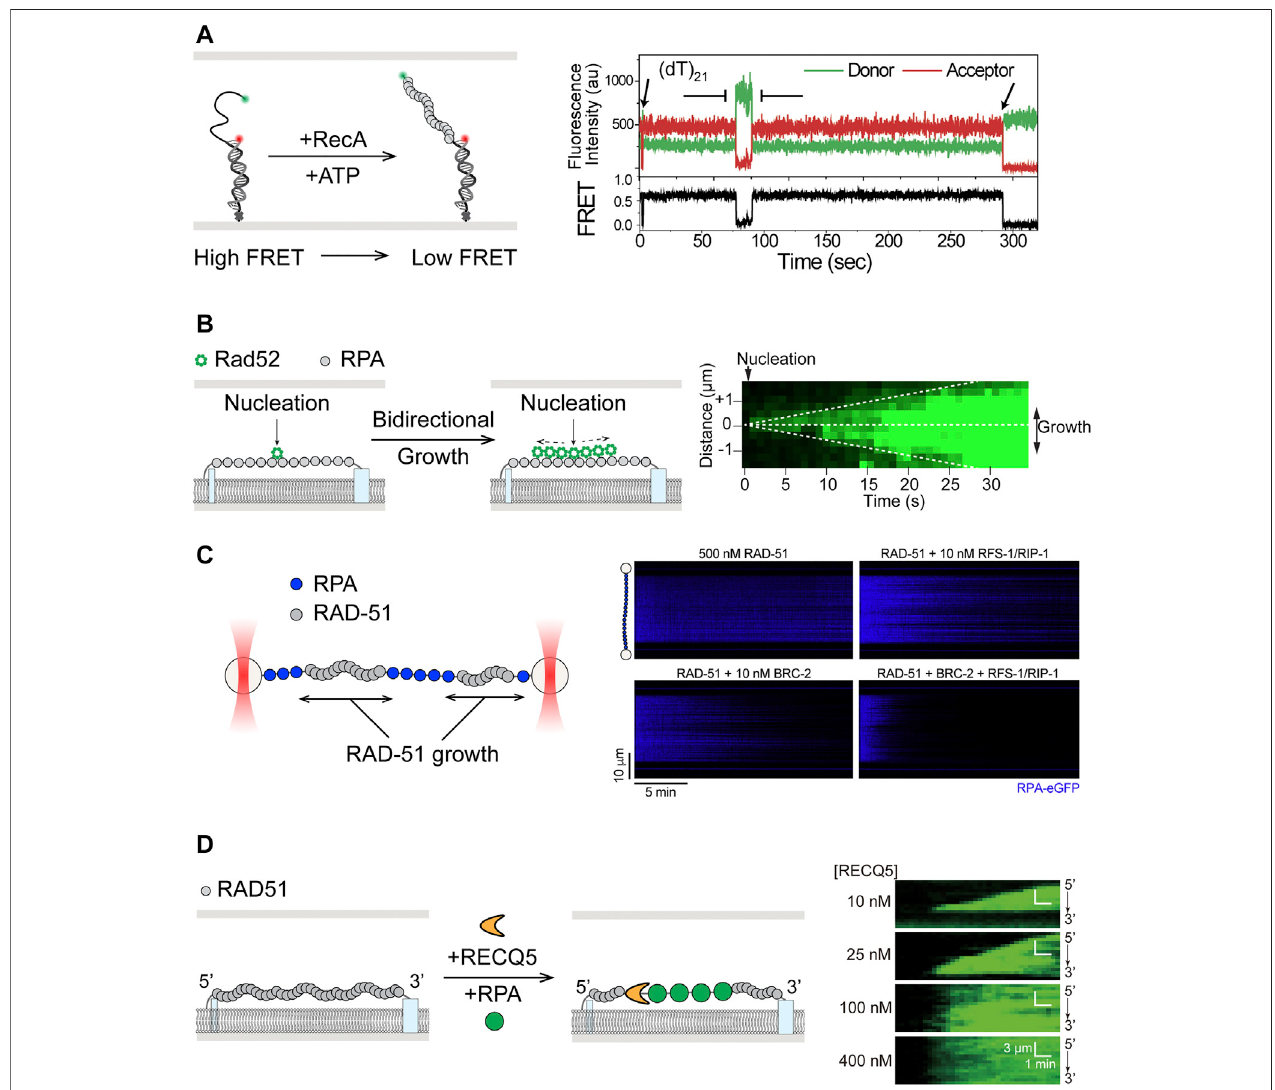
FIGURE 4 | Single-molecule studies of fi lament assembly and dynamics in HR. (A) smFRET study ofassembly of RecA fi laments on 3 ′ -ssDNAoverhang of duplex DNA substrates, where formation of RecA fi laments leads to further separation of the donor and acceptor fl uorophores and lower FRET ef fi ciency. Adapted from Joo et al. (2006). (B) Left: Single-stranded DNA curtain showing bidirectional growth of Rad52 after nucleation on unlabeled RPA-coated single stranded DNA. Right: Kymograph of ssDNA shows double-sided wedge shape in fl uorescence signal over time. Adapted from Gibb et al. (2014b). (C) Left: Scanning confocal fl uorescence imaging of ssDNA held between two optically trapped beads. Right: RAD-51 paralogues RFS-1/RIP-1 was shown to work synergistically with BRC-2 in stimulation of unlabeled RAD-51 fi lament assembly, as re fl ected by the loss of fl uorescent RPA signal in the kymographs. Adapted from Belan et al. (2021). (D) Left: Translocation by RECQ5 on RAD51 fi laments in ssDNA curtain assay, where RAD51 was displaced in the process, as shown by the increase in fl uorescent RPA signal. Right: Kymographs showing increase of fl uorescent RPA signal as RAD51 was removed by RECQ5 from ssDNA. Wedge shape growth, from 3 ′ to 5 ′ , of the fl uorescence signal at low RECQ5 concentrations shows the direction of translocation. Adapted from Xue et al. (2021).